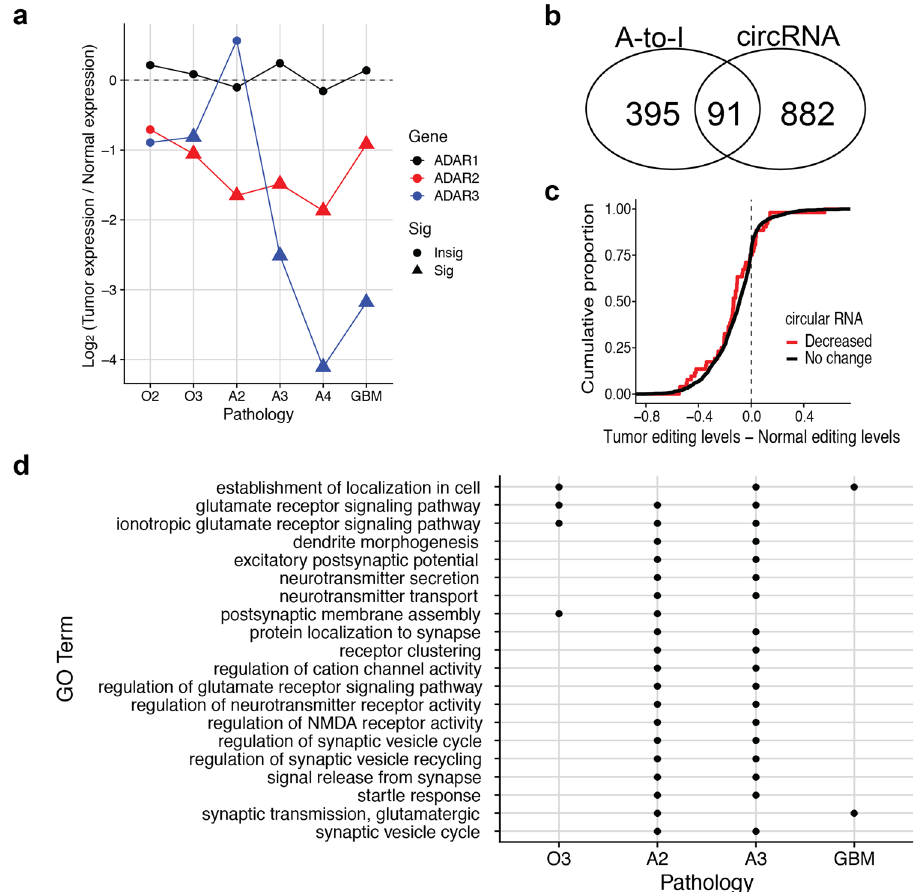
Fig. 4 Integrative understanding of Alu -associated molecular processes in glioma. a Average fold change of mRNA expression levels of A-to-I editing enzyme ADAR families ( ADAR1 , ADAR2 , and ADAR3 ). Statistical signi fi cance of differential expression was determined by a R package DESeq2: signi fi cant if FDR-adjusted p value < 0.05 ( N = 12, 18, 8, 10, 4, 30 tissues for O2, O3, A2, A3, A4, GBM, respectively). b Venn diagram of the genes with differentially- edited A-to-I editing sites and the genes showing differential expression rates of circular RNA. c The distributions of A-to-I editing level changes in tumors relative to matched normal tissues were compared between the two gene groups made by whether genes show the decreased circular RNA expression rates in tumors relative to matched normal tissues (two-sided Kolmogorov-Smirnov test p value: 0.07202, N = 1578 A-to-I editing sites). d Gene ontology terms that were enriched with the genes whose gene bodies harbor the differentially-edited A-to-I editing sites between tumor and matched normal tissues. The terms found in at least two pathologies of glioma were